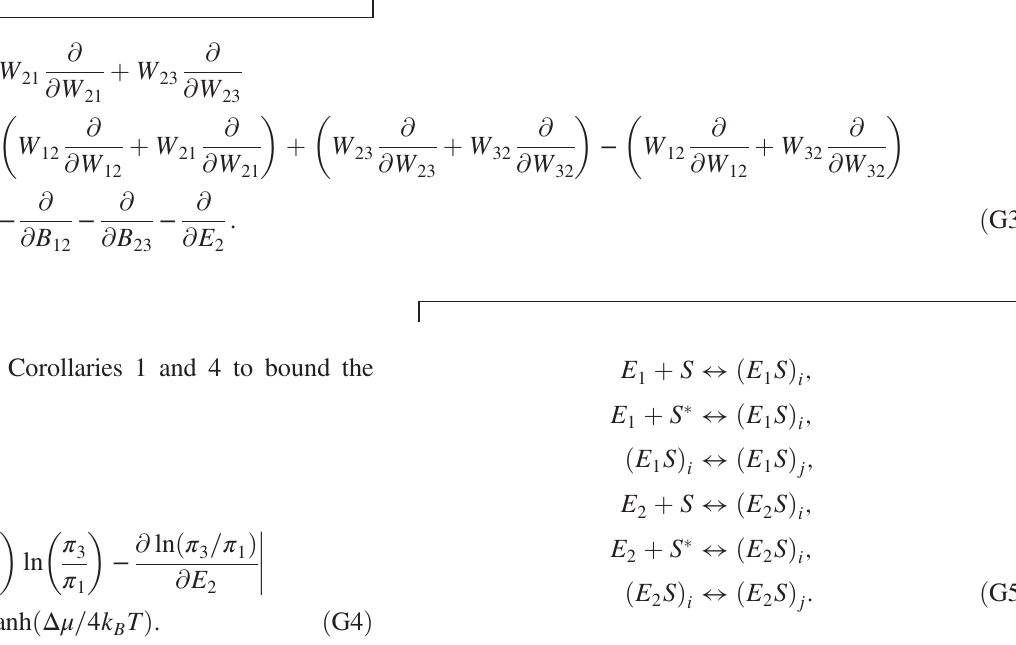
and E 2 ; [35]. tot tot